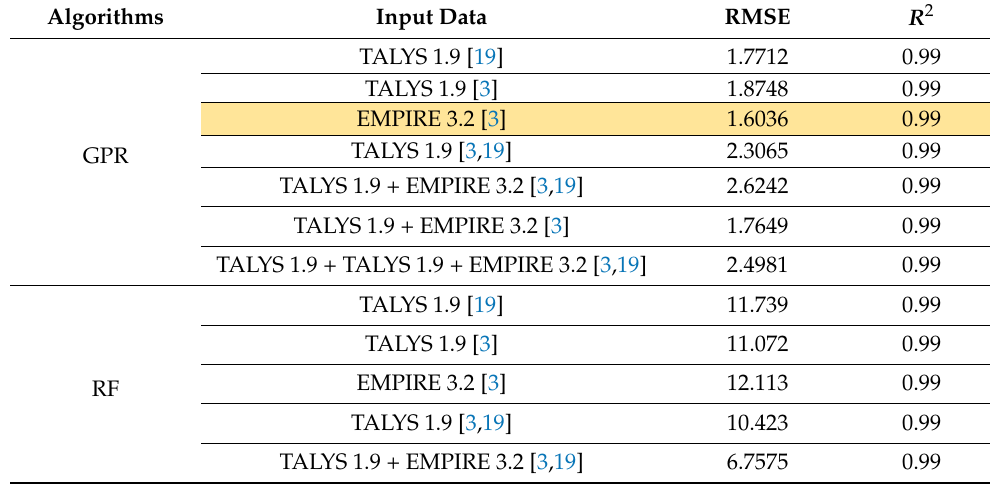
Table A1. Feature Selection by Recursive Feature Elimination for CEP cross-section using Gaussian process regression (GPR), random forest (RF) and support vector machine (SVM). Crude estimation property (CEP) is used as input includes EMPIRE 3.2 and TALYS 1.9 data from Luo and Jiang [3] and TALYS1.9 data from Naik et al. [19]. The machine learning model with R 2 closed to 1 and lowest RMSE is highlighted in